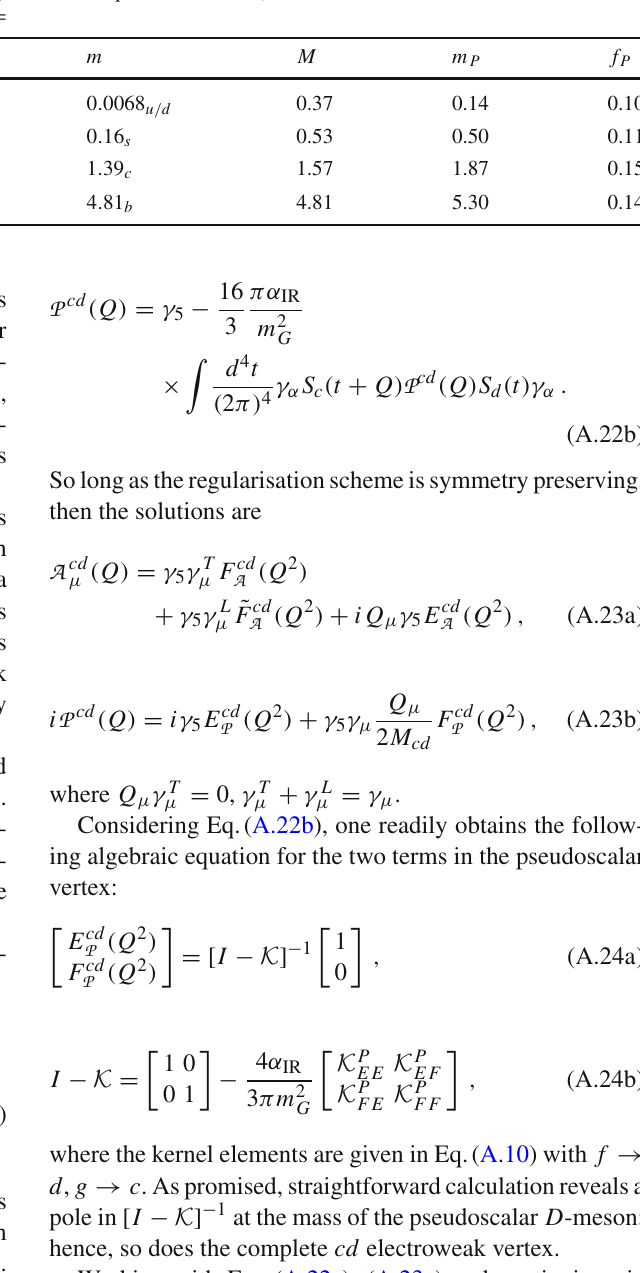
0 . 24GeV. Empirically, at a sensible level of precision [70]: m π = 0 . 14, f π = 0 . 092; m K = 0 . 50, f K = 0 . 11; m D = 1 . 87, f D = 0 . 15; m B = 5 . 30, f B = 0 . 14. (We assume isospin symmetry and list dimen- sioned quantities in